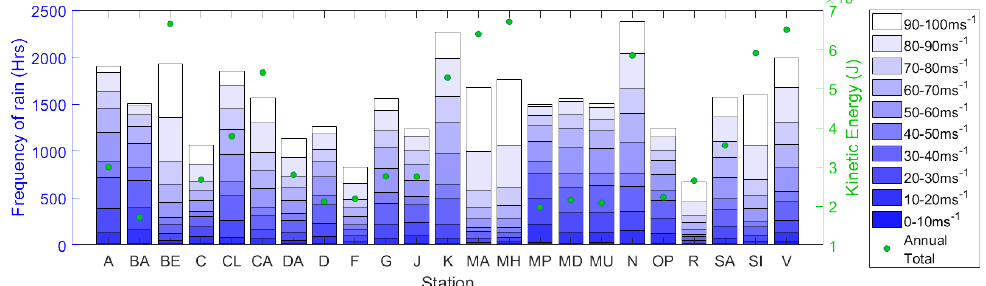
Figure 9. Number of rain hours and E K , A for each impact speed bin, at each station. The highest R 2 (0.48) for both E K , A and n A regression models was for two predictor variables, X and Y. There was little correlation (<=0.30) between n AR and other geographical parameters. In this case, the RMSE was particularly high ( ∼ 132 kJ), equal to ∼ 20% of E K , MH . Interestingly, the largest R 2 (0.57) was for n A ,70 − 80 and all three predictor variables. Using the regression estimates, E K , A is given by: